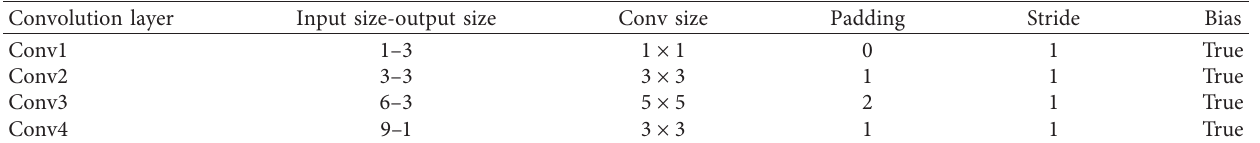
Table 2: Parameters of low-frequency channel.